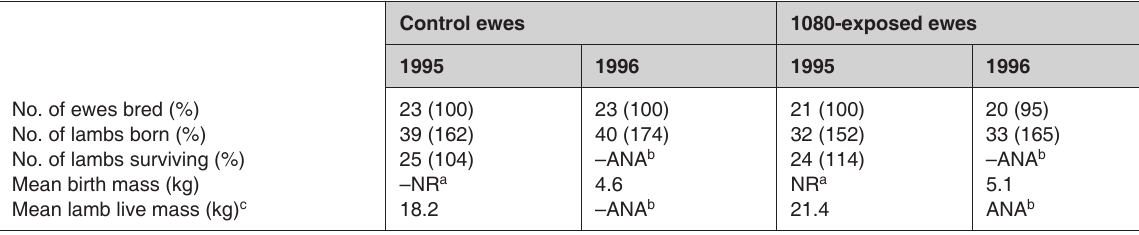
TABLE 3 Reproductive performance of ewes following exposure to sodium monofluoroacetate